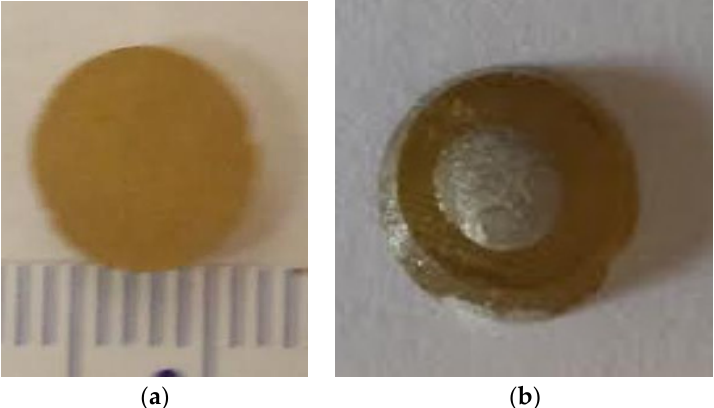
Figure 1. S ‐ ZnSe ( a ) polished crystal slab and ( b ) parallel polished slab with silver dot used for electrical measurements.